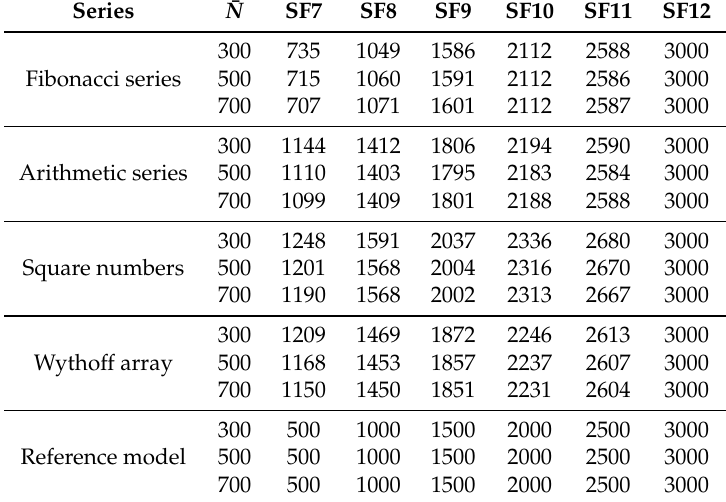
Table 5. Comparison of proposed approach with the reference method based on the distance of individual SF outer boundaries from the gateway (values in meters).